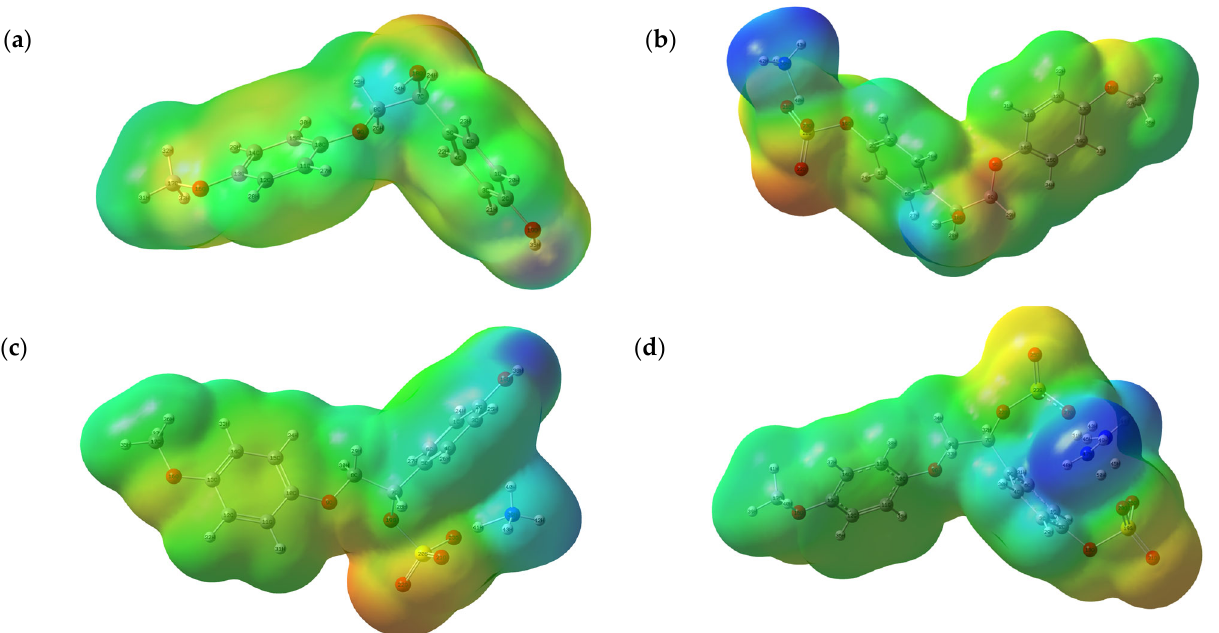
Figure 10. 3D plot of the MEP surface for the investigated molecules: initial β -O-4 lignin ( a ), and sulfated β -O-4 lignin with the sulfate group localized at the aromatic ( b ), alkyl ( c ), and alkyl and aromatic ( d ) hydroxo groups.